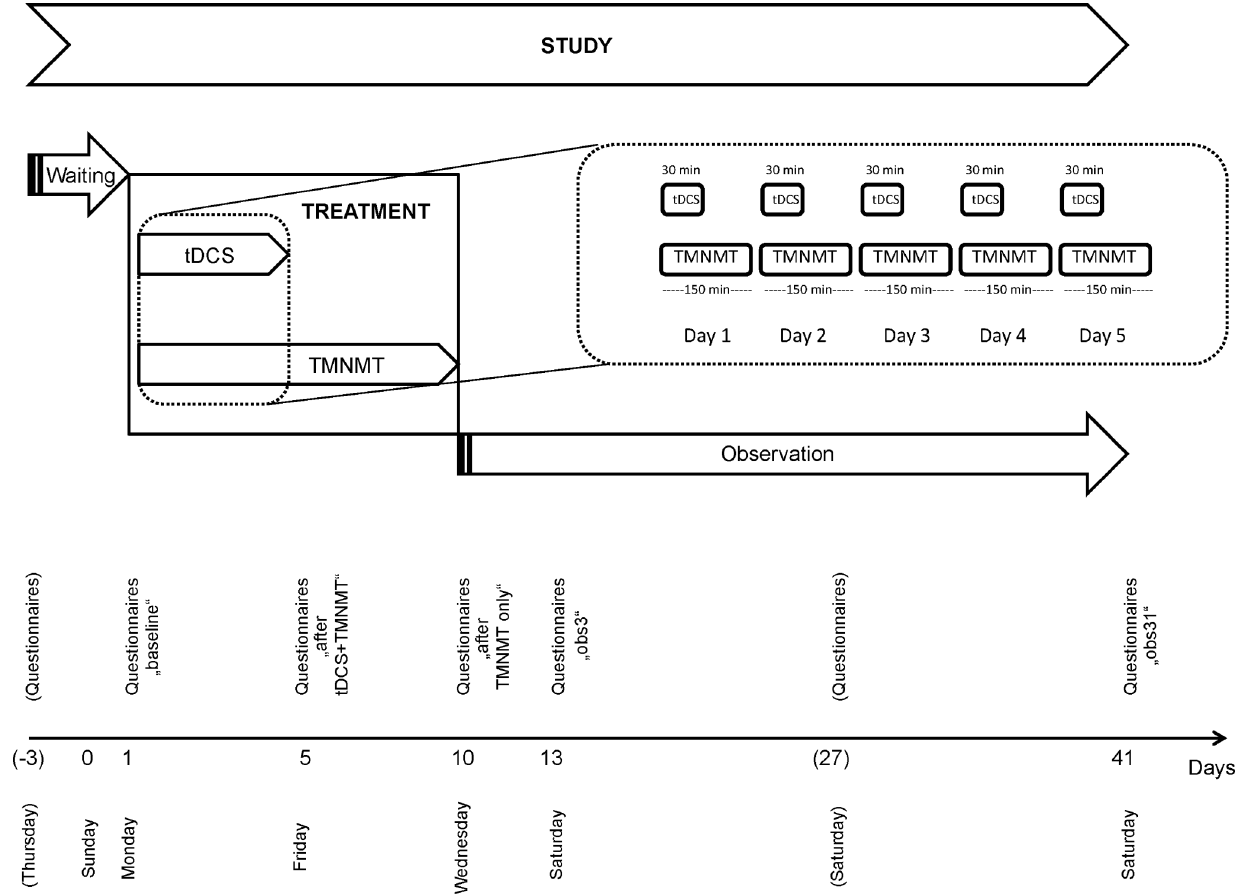
Figure 1. Study design. For each participant, the study took 45 days (4 days of pre-treatment waiting, 10 days of treatment, and 31 days of post- treatment observation). During the initial 5 days of treatment, transcranial direct current stimulation (tDCS) and the tailor-made notched music training (TMNMT) were applied simultaneously; during the remaining 5 days of treatment, only TMNMT was applied. Throughout the study, perceived tinnitus-related distress data were sampled repeatedly.